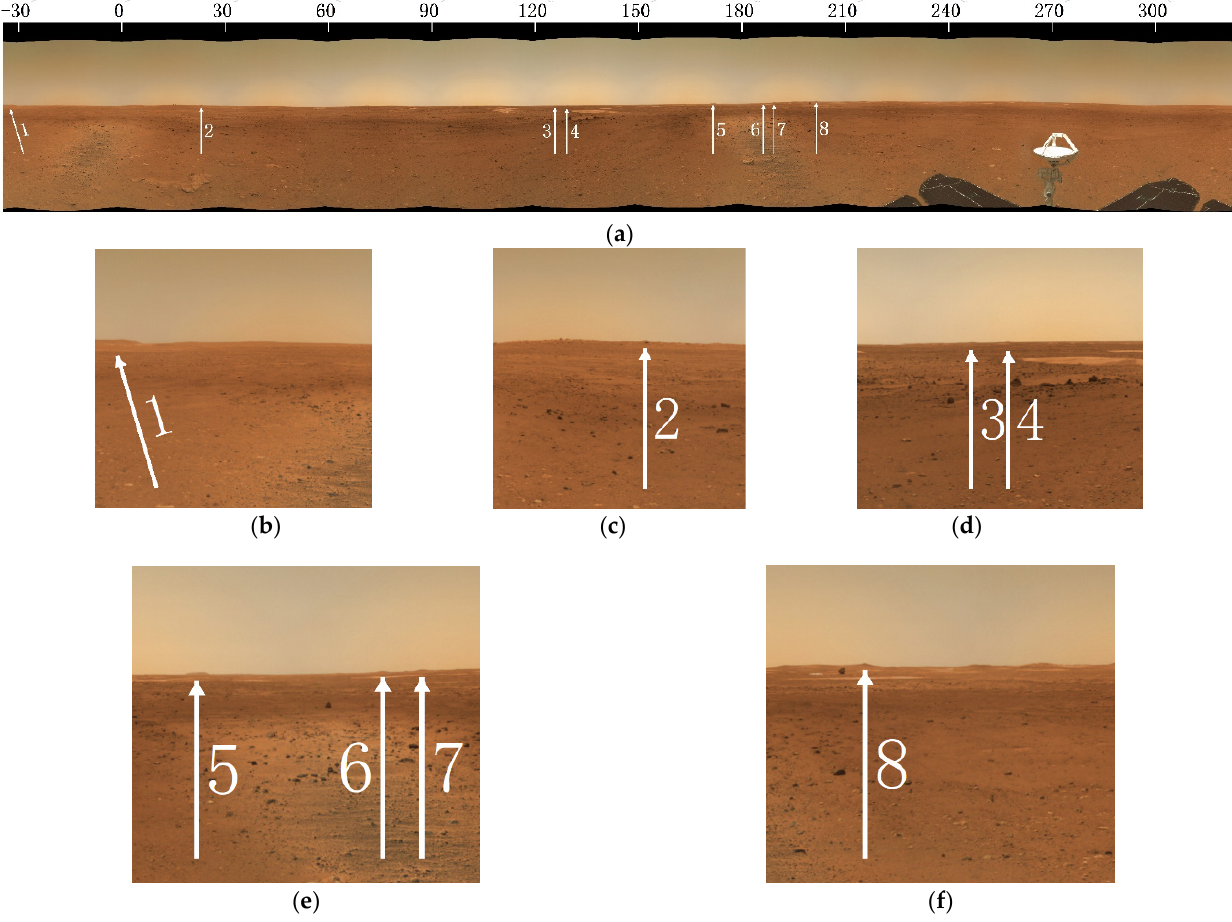
Figure 5. The 360° panorama of NaTeCam images with extracted landmarks. The white arrows point to the landmarks. ( a ) shows the eight landmarks extracted in NaTeCam panorama; ( b )–( f ) show the regional enlarged images of landmarks.